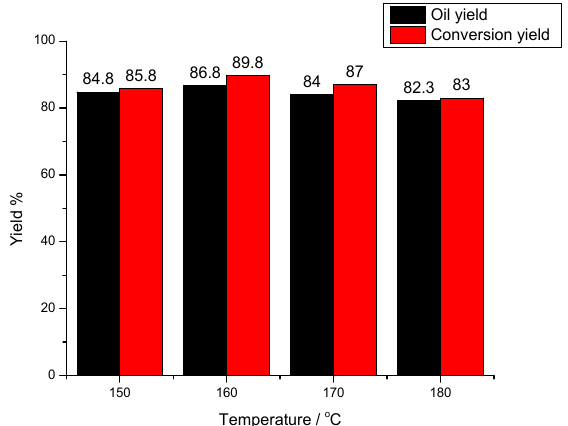
Figure 1. E ff ect of reaction temperature on lignin conversion. Reaction conditions: reaction time was 1 h, solvent ratio of methanol to glycerol was 2:1, catalyst dosage was 5.0 wt